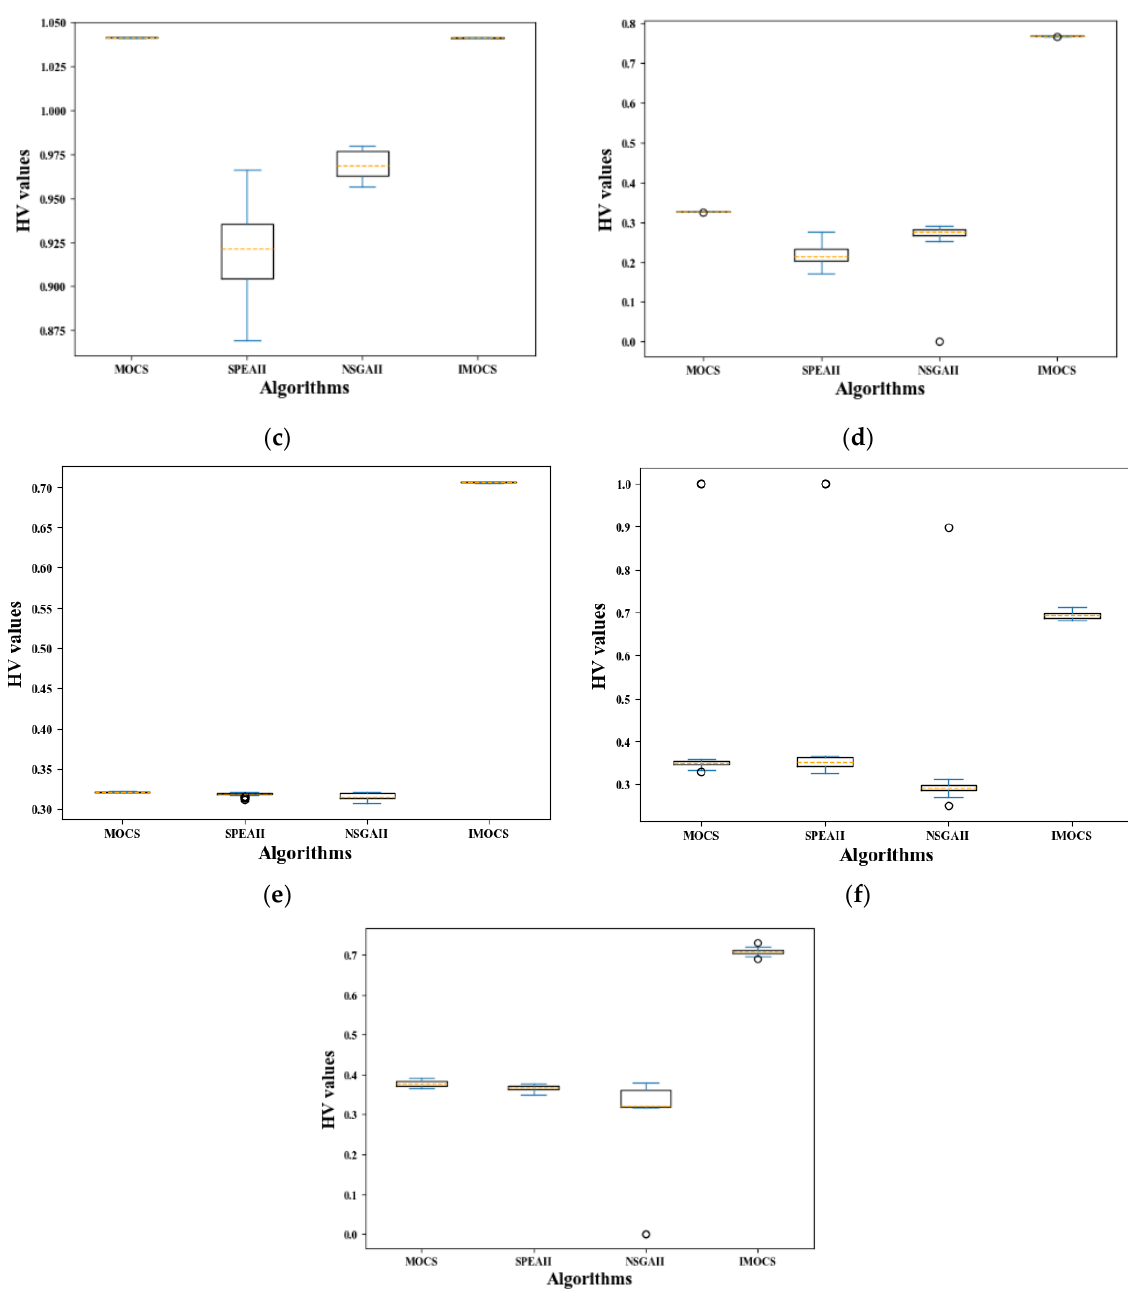
Figure 11. The results of HV test problem over all algorithms. ( a ) ZDT1, ( b ) ZDT2, ( c ) ZDT3, ( d ) ZDT4, ( e ) ZDT6, ( f ) DTLZ2, and ( g ) DTLZ4.